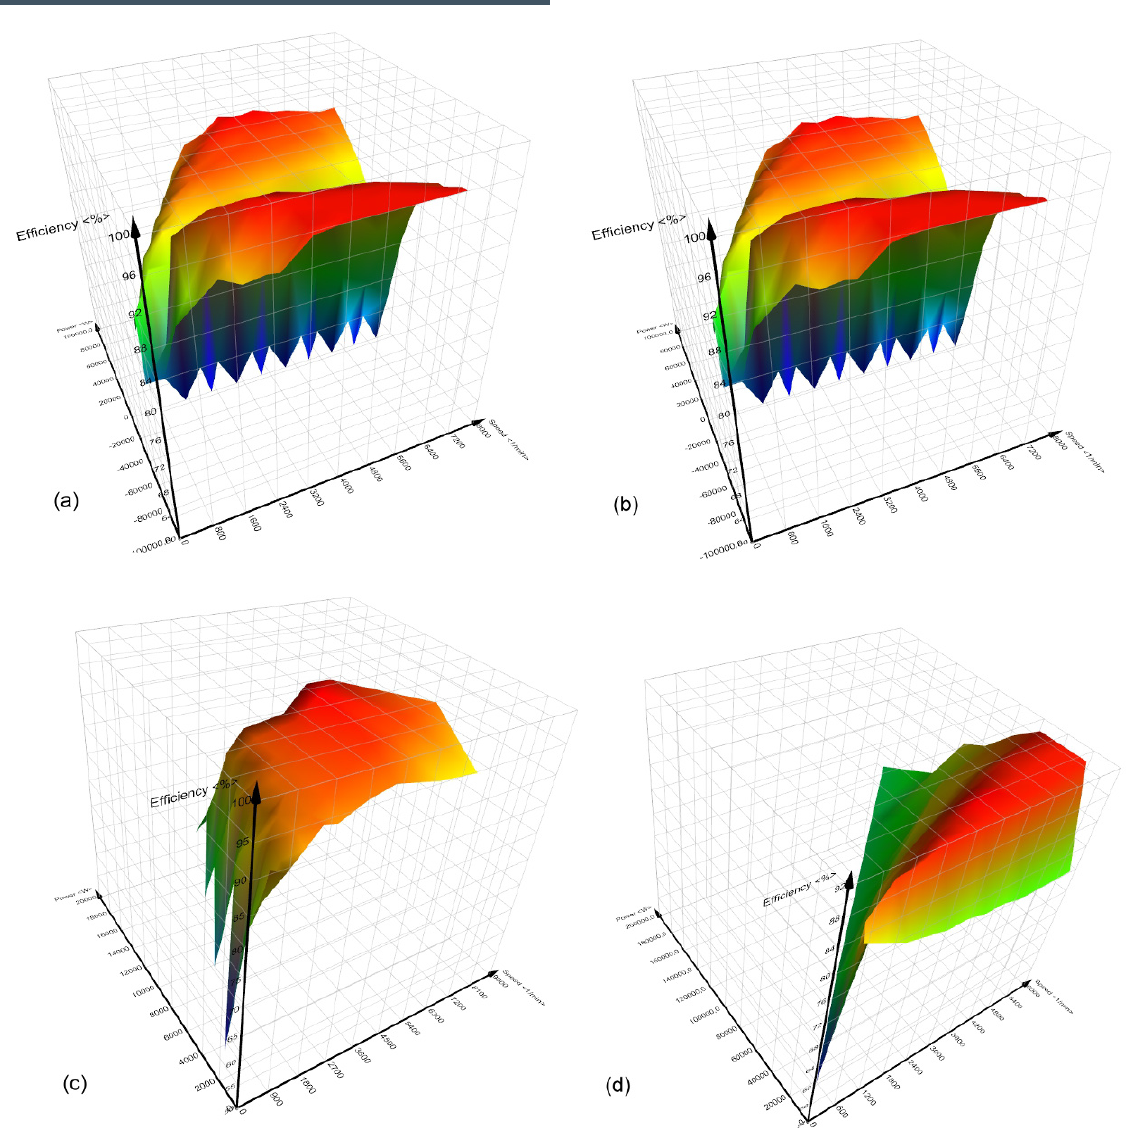
Figure 5. Efficiency over power and speed of the electrical machine in case of: Electric vehicle (a), Electric vehicle with range extender (b), Hybrid vehicle with CVT (c), Hybrid vehicle with planetary gearbox (d).